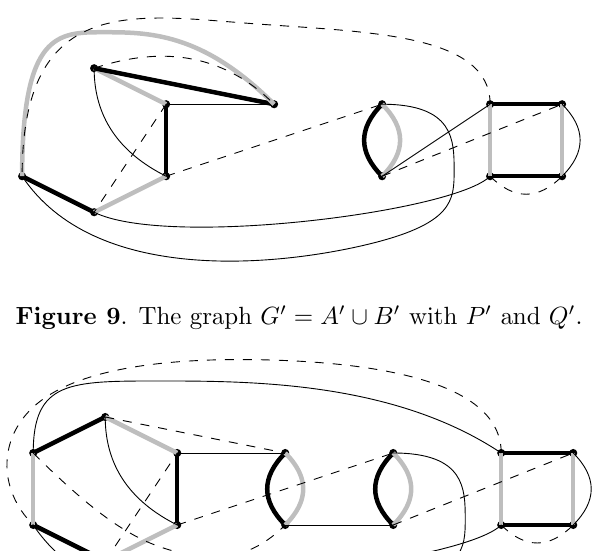
Figure 8 . The graph G 00 = A 00 [ B 00 with P 00 and Q 00 .